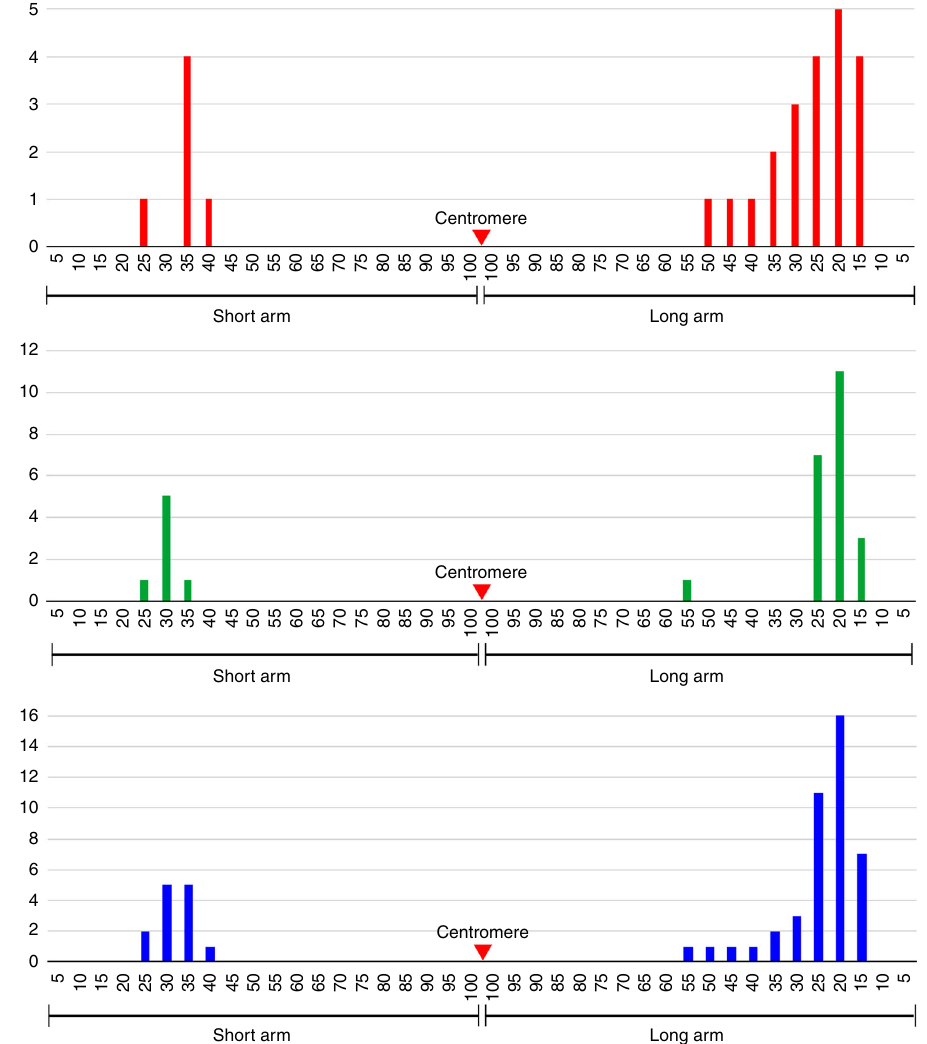
Fig. 4 Distribution of chromosomal exchange positions on chromosome 10. Upper panel, middle panel, and lower panel show exchange positions (EPs) on chromosome 10 of B73, Mo17, and combined chromosome 10, respectively. Each interval on the x -axes represents 5% of the length of the short or long arm. y- axes indicate the number of EPs within a particular 5% of the short arm or long arm. The red triangles point to the centromere position on the